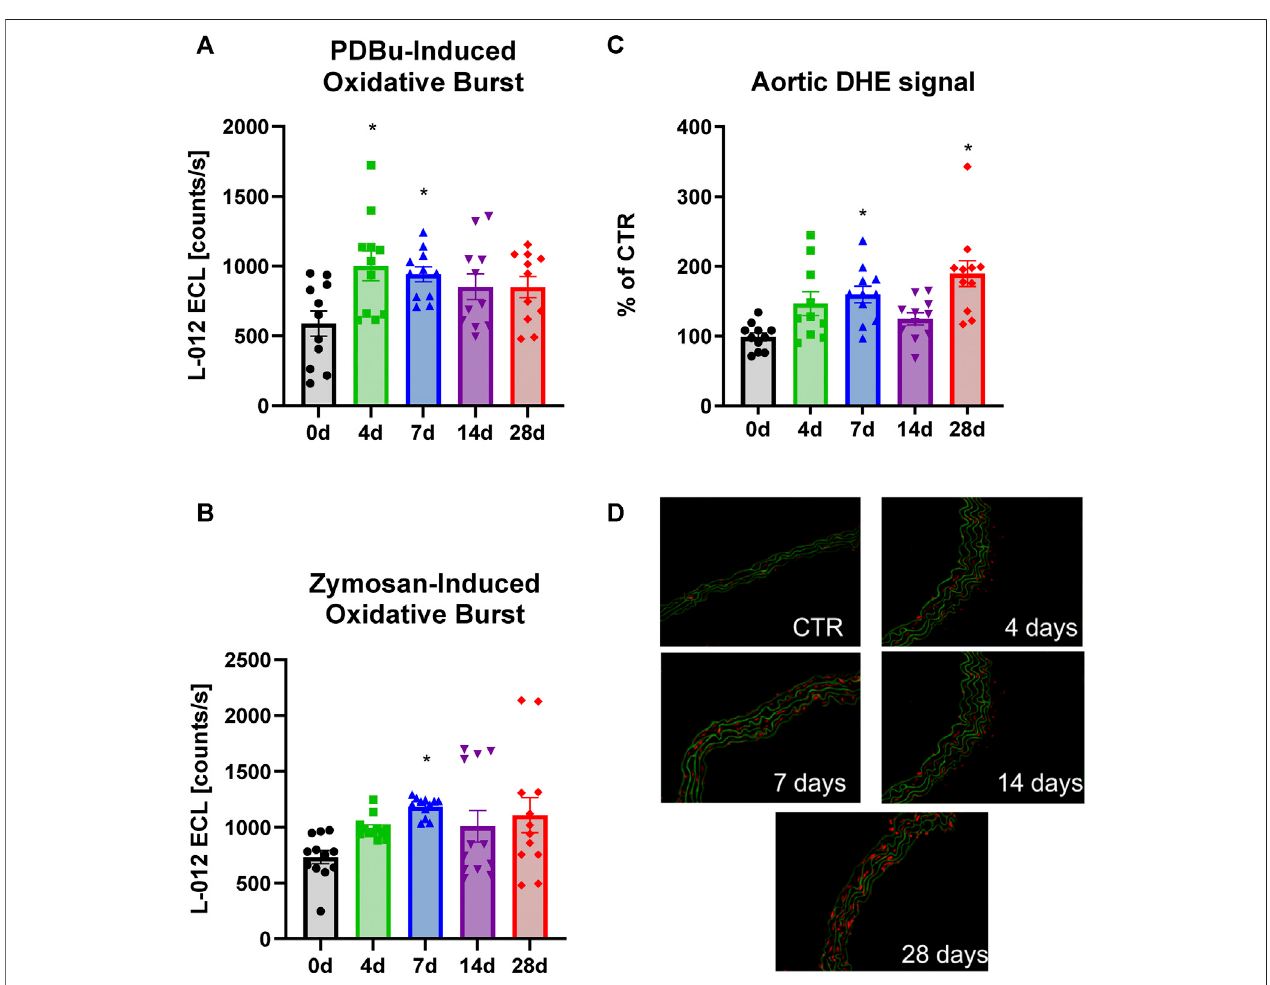
FIGURE 4 | Effects of long-term noise exposure on ROS formation in whole blood and aorta. Stimulation of oxidative burst in whole blood with the phorbol ester (PDBu) (A) or the fungal pyrogen (zymosan A) (B) indicates that noise induces a heightened ROS response by leukocytes. (C) In aorta, staining with DHE revealed a gradualtrendforincreasedROSlevelsalongwiththeincreasingdurationofnoisetreatment. (D) RepresentativeDHEstainingsareshownforallgroups;red fl uorescence indicatesROSformationandgreen fl uorescencecomefromtheauto fl uorescenceofthebasallaminae. Datapointsfor (A,B) aremeansfrom8replicatesofpooled whole blood from the indicated number of animals per group. Data points for (C) represent means of two to four stainings per individual animal. Statistical analysis with one-way ANOVA with Tukey ’ s multiple comparison test. p < 0.05: * vs respective to 0d, # to 4d, $ to 7d, § to 14d and + to 28d.